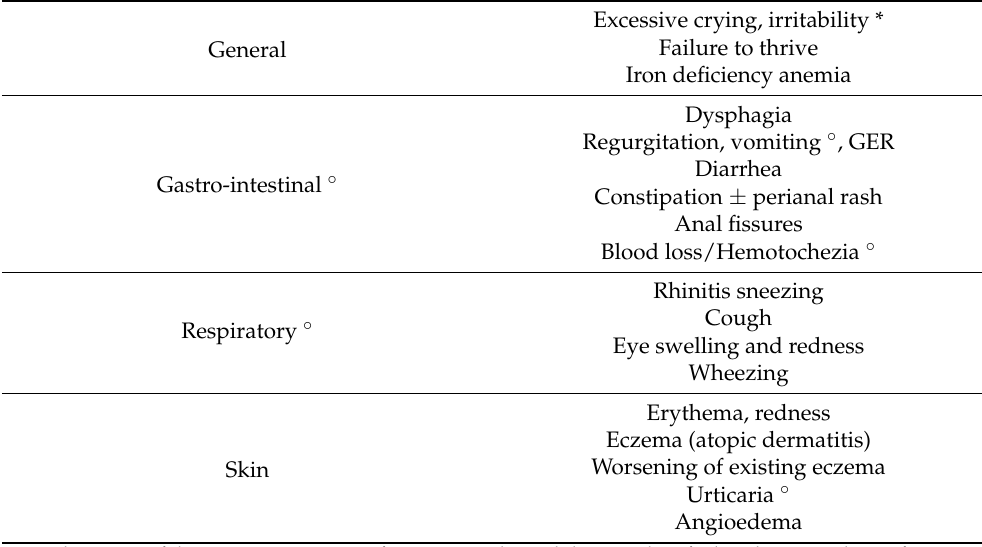
Table 2. Signs and symptoms eventually associated with cow’s milk intake